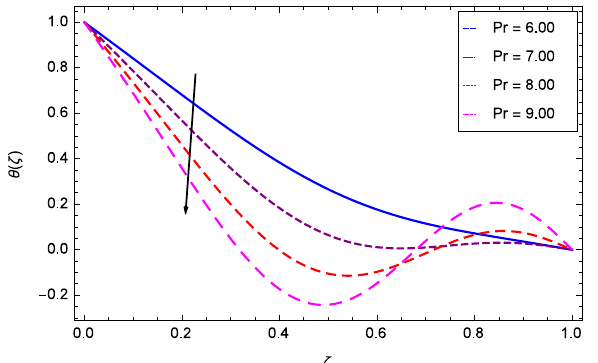
Figure 15. Analysis through Prandtl number Pr and temperature θ ( ζ ).